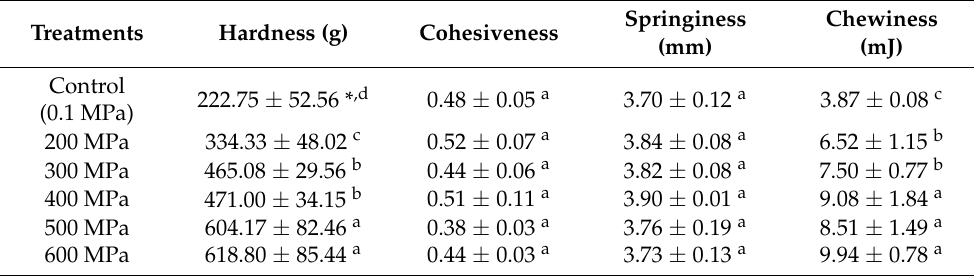
Table 3. Values of hardness, cohesiveness, springiness, and chewiness in fresh mustard pickles after HHP processing at 200, 300, 400, 500, and 600 MPa for 5 min.